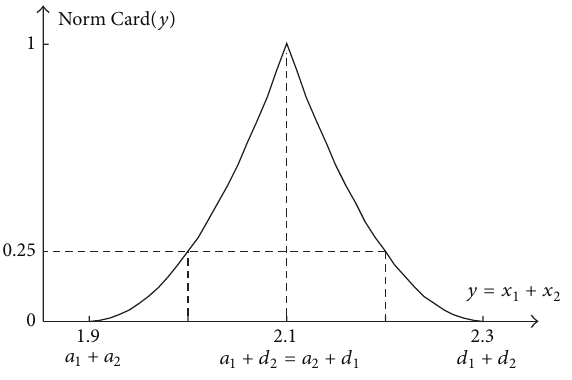
Figure 10: Normalised cardinality distribution Norm Card (𝑦) of the occurrence of particular values of the sum 𝑦 = 𝑥 1 + 𝑥 2 being the 2D representation of the 4D addition result of two independent fuzzy numbers “about 1.0” and “about 1.1” shown in Figure 7.